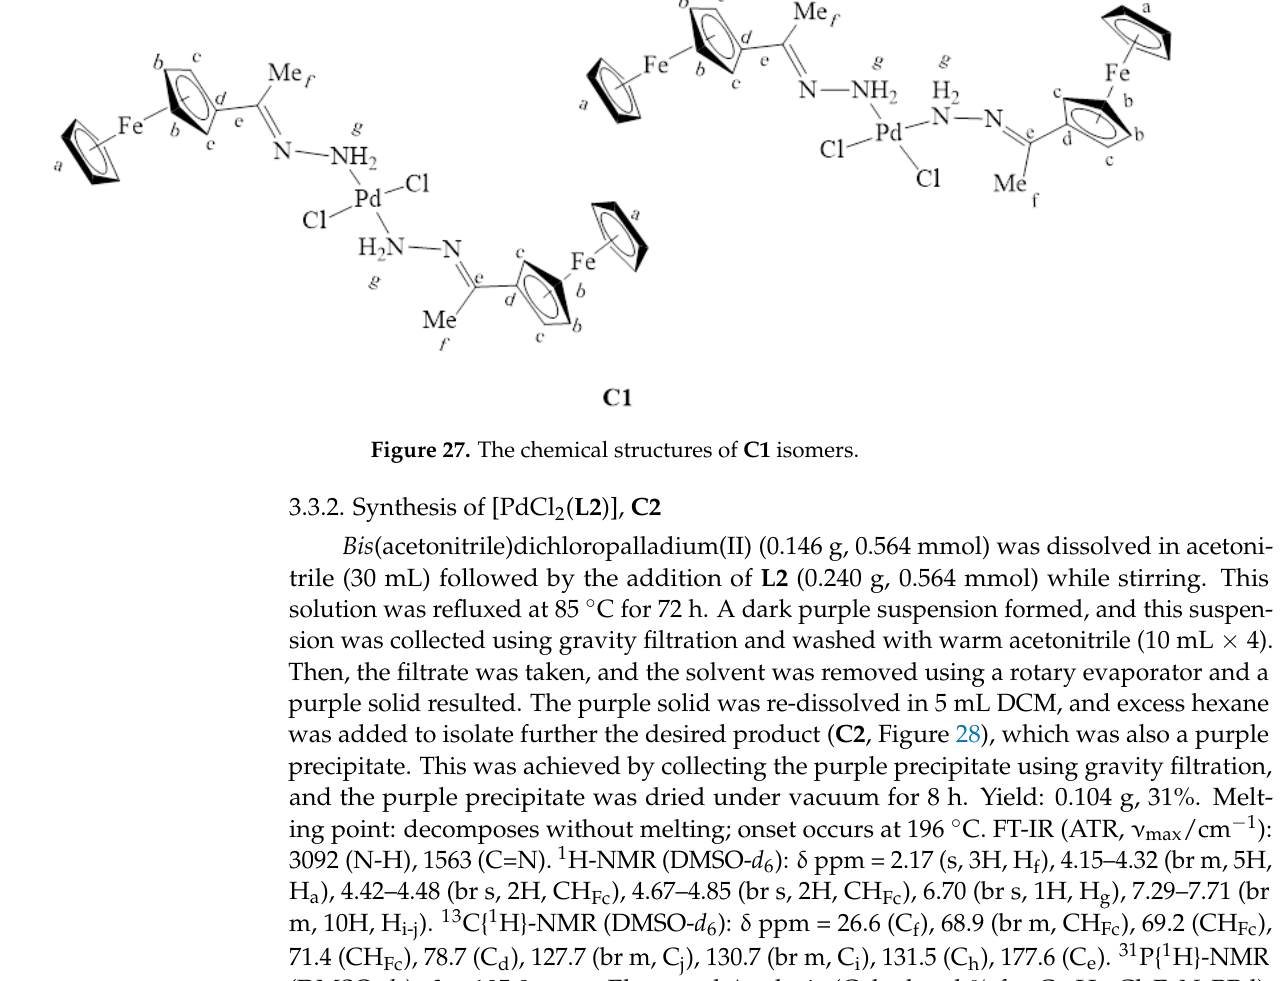
Figure 28. The chemical structure of C2 . 3.3.3. Synthesis of [PdCl 2 ( L3 )], C3 Bis (acetonitrile)dichloropalladium(II) (0.0757 g, 0.292 mmol) was added to a solution of L3 (0.150 g, 0.292 mmol) in 30 mL of dry DCM. This solution was then stirred at room temperature for 24 h. A purple precipitate formed and was collected by gravity filtration. To obtain more of the purple solid product, the solvent was removed from the filtrate to give C3 (Figure 29). The combined purple solid ( C3 ) was dried under vacuum for 4 h. Yield: 0.0987 g, 49%. Melting point: decomposes without melting, onset occurs at 150 °C.